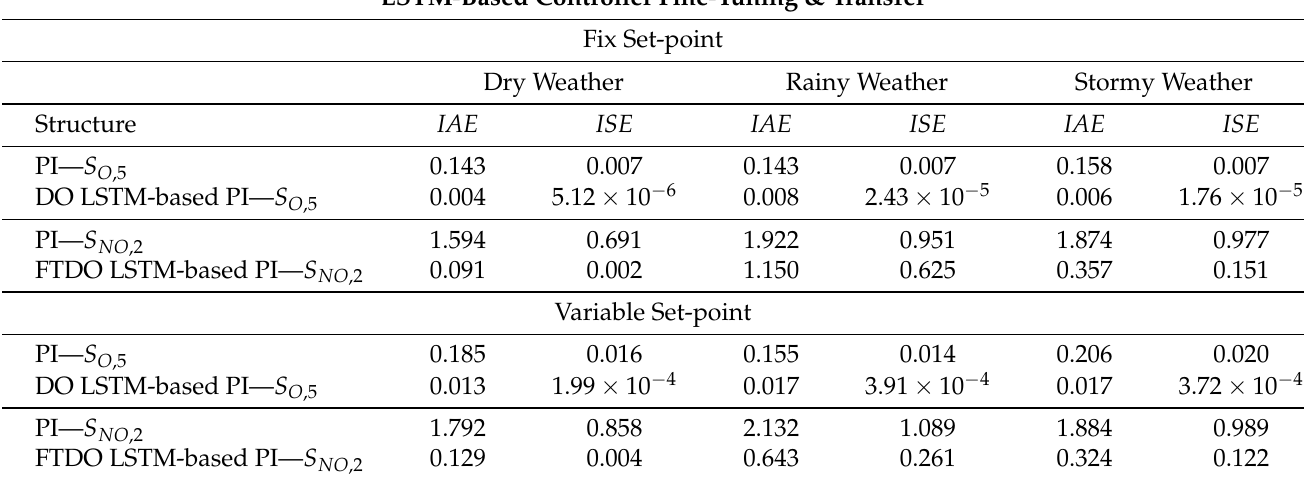
Table 4. Control performance when the DO LSTM-based PI derived from the DO control loop is transferred into the NO control loop. Then, the NO controller is fine-tuned with data from the default PI controller managing the S NO ,2 . LSTM-Based Controller Fine-Tuning & Transfer Fix Set-point Dry Weather Rainy Weather Stormy